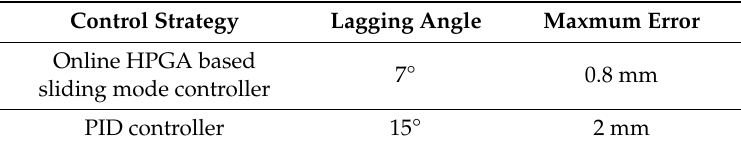
Figure 7. Variation of the grating ruler position (the proposed method in the blue line, PID controller in the red line, and the desired sine signal in the green line). Table 3. Performance of the proposed method and PID controller.